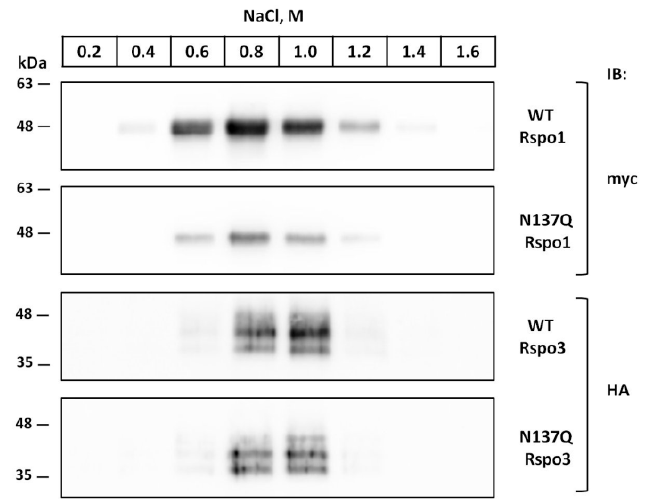
Figure 10. Effect of N-glycosylation on the heparin-binding ability of Rspo1 and Rspo3. Concentrated conditioned media from WT Rspo1, WT Rspo3 and their glycomutants-expressing cells were incubated with heparin-agarose, and the bound proteins were eluted with buffers containing increasing concentrations of NaCl. The presence of Rspo proteins in each eluate was detected by immunoblot analysis using anti-myc or anti-HA antibodies. Data shown here included a representative image of two independent experiments with similar results.